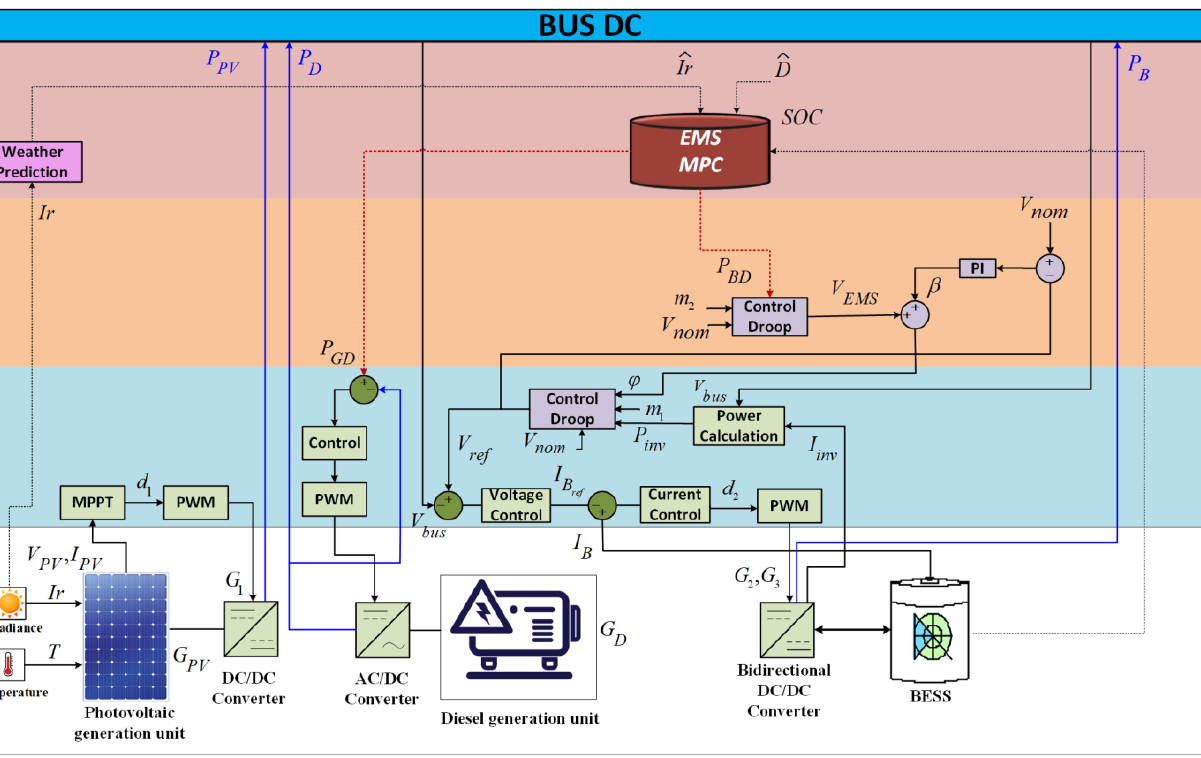
Figure 2. Control architecture.